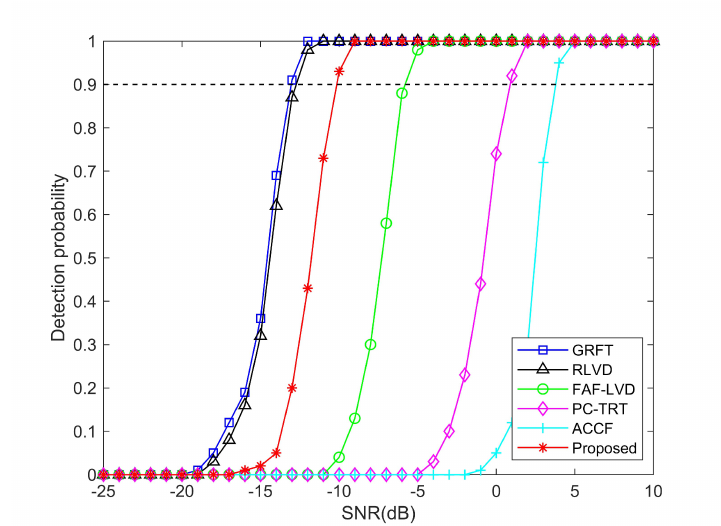
Figure 10. Detection probability curves of different methods.